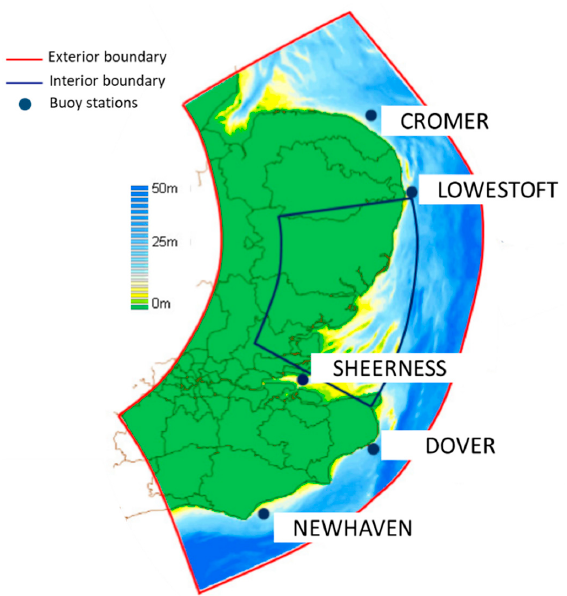
Figure 1. Model domain; red, and blue contours indicate model exterior, and interior boundaries respectively. Blue points indicate buoy stations: Cromer, Lowestoft, Dover, Newhaven, Sheerness.